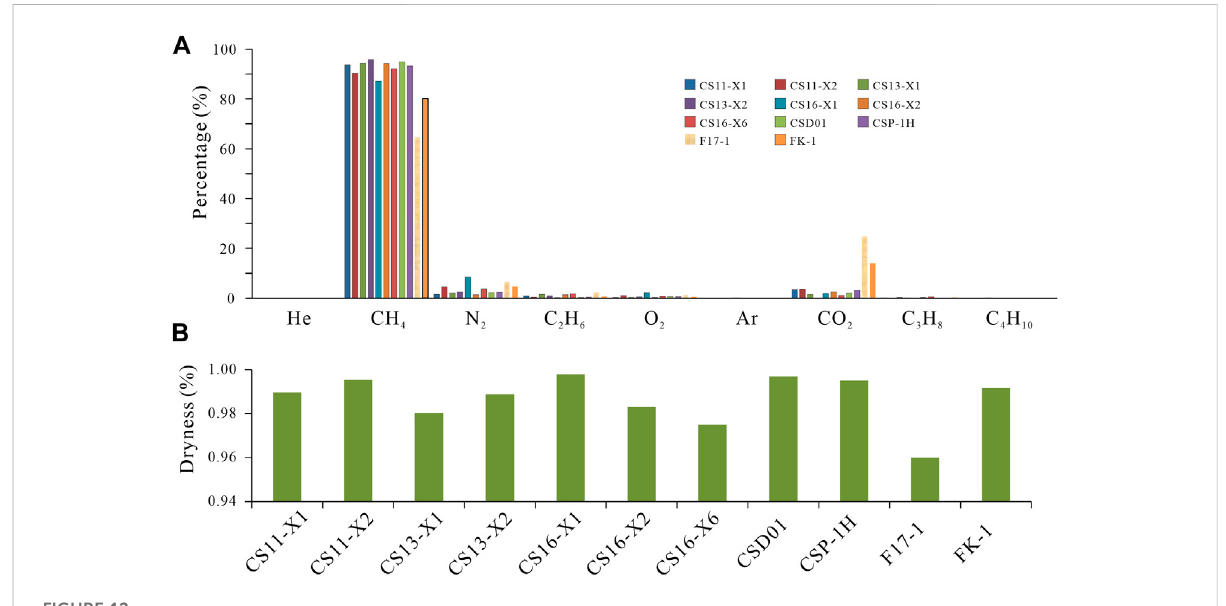
FIGURE 12 Composition (A) and dryness (B) of coalbed gases in the Fukang